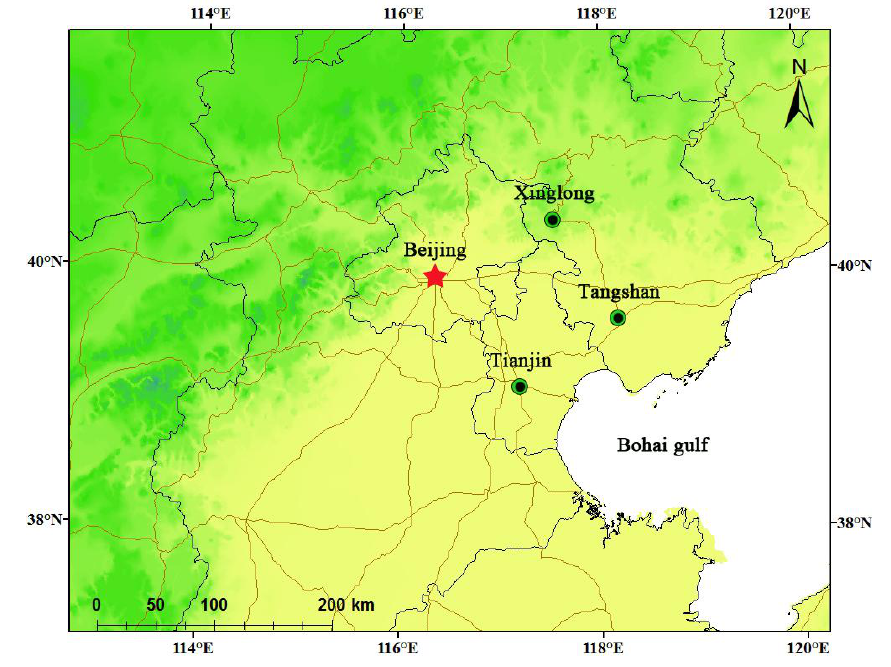
Figure 1. Location of Tangshan station in the Beijing-Tianjin-Hebei